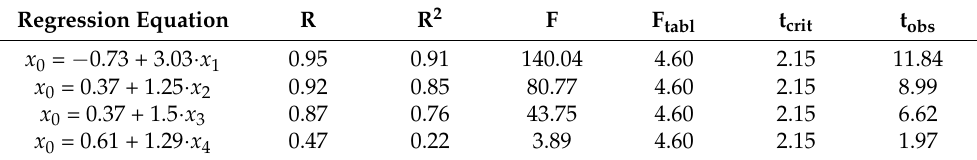
Table 7. Obtained pair linear regression equations for the studied textile companies. Regression